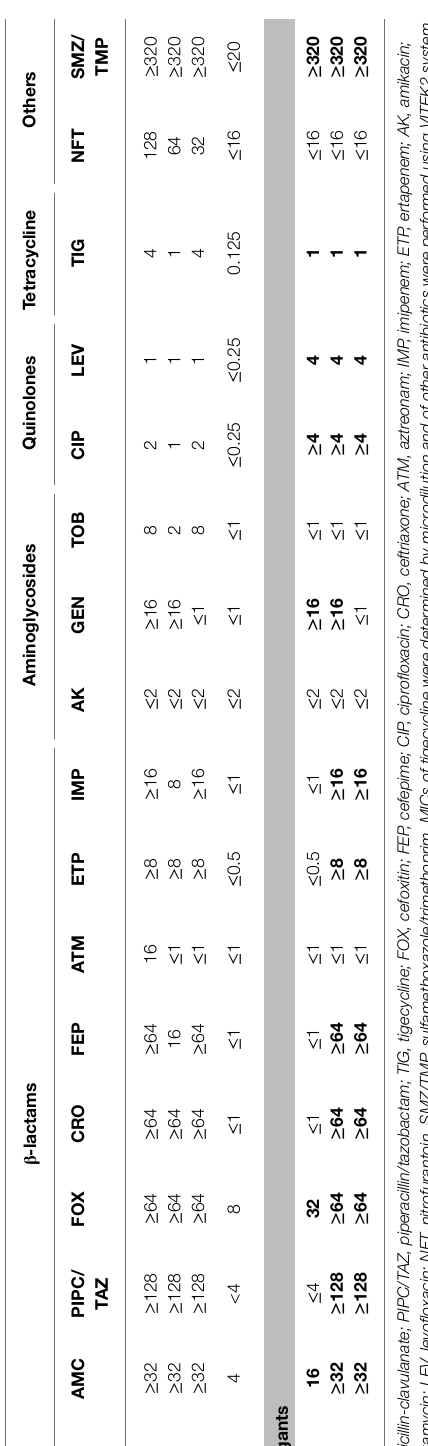
34,827 bp ( Figure 2 ).